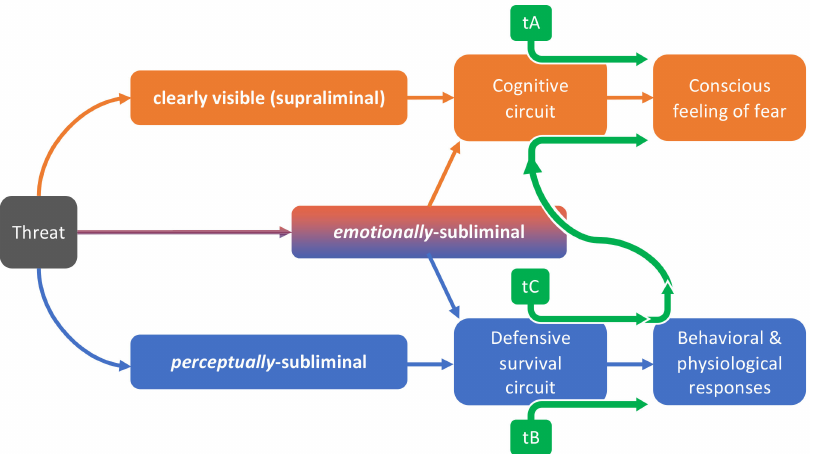
Figure 2. Integration of the bifactorial model previously proposed by Frumento and colleagues in 2021 [6] shows the impact of different levels of exposure to threats: while supraliminal and per- ceptually subliminal stimuli, respectively, impact the cognitive or the defensive survival circuits, emotionally-subliminal stimuli could impact on both circuits simultaneously. As a consequence, expo- sure therapies administering supraliminal stimuli only (tA) could leave behavioral and physiological correlates of fear dormant [23]; exposure therapies administering perceptually-subliminal stimuli only (tB) are ineffective in reducing the conscious feeling of fear; exposure therapies administering perceptually-subliminal, emotionally-subliminal and supraliminal stimuli in this order (tC) could maximize the benefit coming from each